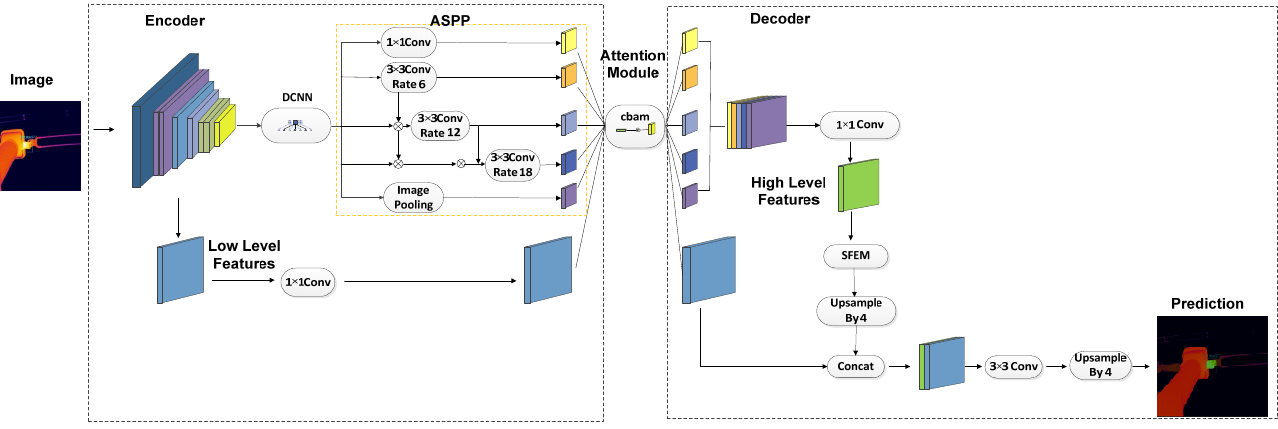
Figure 3. CS_DeeplabV3+ network structure.